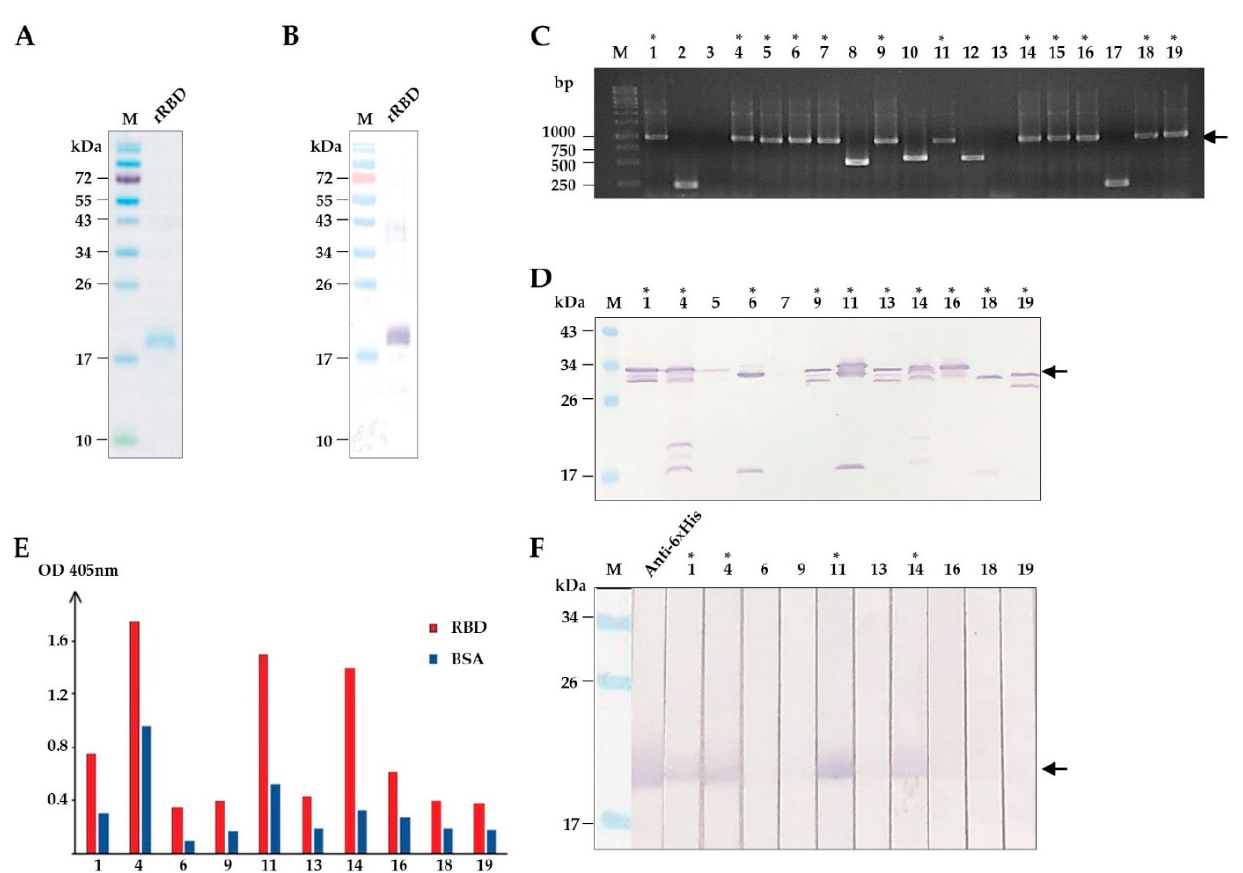
Figure 1. Production of recombinant (r) RBD and selection of HuscFvs that bind to rRBD. ( A ) SDS-PAGE-separated and CBB stained purified rRBD. ( B ) Western blot pattern of rRBD that corresponds to lane rRBD in ( A ) detected by anti-6X His antibody. ( C ) Screening of phage-infected E. coli clones that contained rRBD-bound phage clones for huscfvs by PCR. Arrowhead indicates the expected amplicon of intact huscfvs about 1000 base pairs (bp). ( D ) Screening of soluble HuscFvs contained in the lysates of E. coli carrying huscfv -phagemids by Western blotting. Asterisks indicate the clones that produced HuscFvs. Arrowhead indicates the expected molecular mass of HuscFvs about 30–35 kDa. ( E ) Binding assay of soluble HuscFvs in E. coli lysates to rRBD by indirect ELISA, using BSA as the control antigen. ( F ) Binding assay of soluble HuscFvs in E. coli lysates to rRBD blotted onto nitrocellulose strips. Asterisks indicate the clones that their HuscFvs bound to rRBD. Arrowhead indicates the rRBD-HuscFv reactive bands. Lane Anti-6 × His was rRBD probed with anti-6X His antibody that served as a positive control for rRBD binding. The number on each lane in ( C , D , F ) indicates the number of the phage-transformed E. coli clone. The asterisks in ( C , D , F ) indicate HuscFv-displayed phage-infected E. coli clones that carried intact huscfvs , expressed soluble HuscFvs, and produced rRBD-bound HuscFvs, respectively. Lanes M and numbers on the left of ( A , B , D , F ) are protein molecular mass marker and protein molecular weights in kDa, respectively. Lane M and numbers on the left of ( C ) are DNA ladder and DNA sizes in bp, respectively.